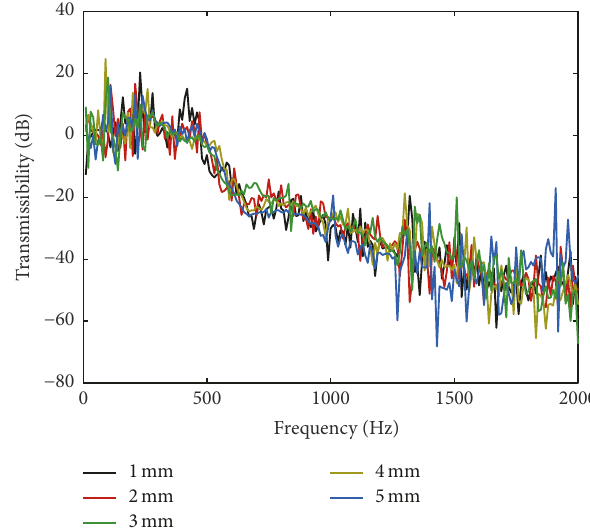
Figure 7: Results of the shaker excitation experiment.